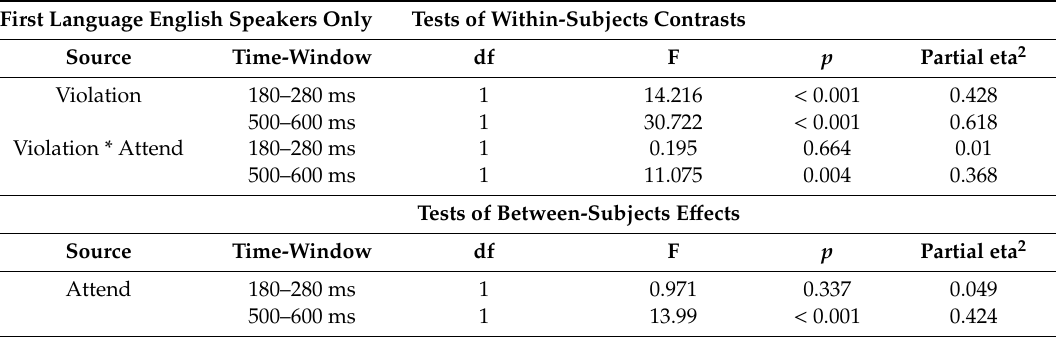
Table 3. ERP statistics for first-language English speakers